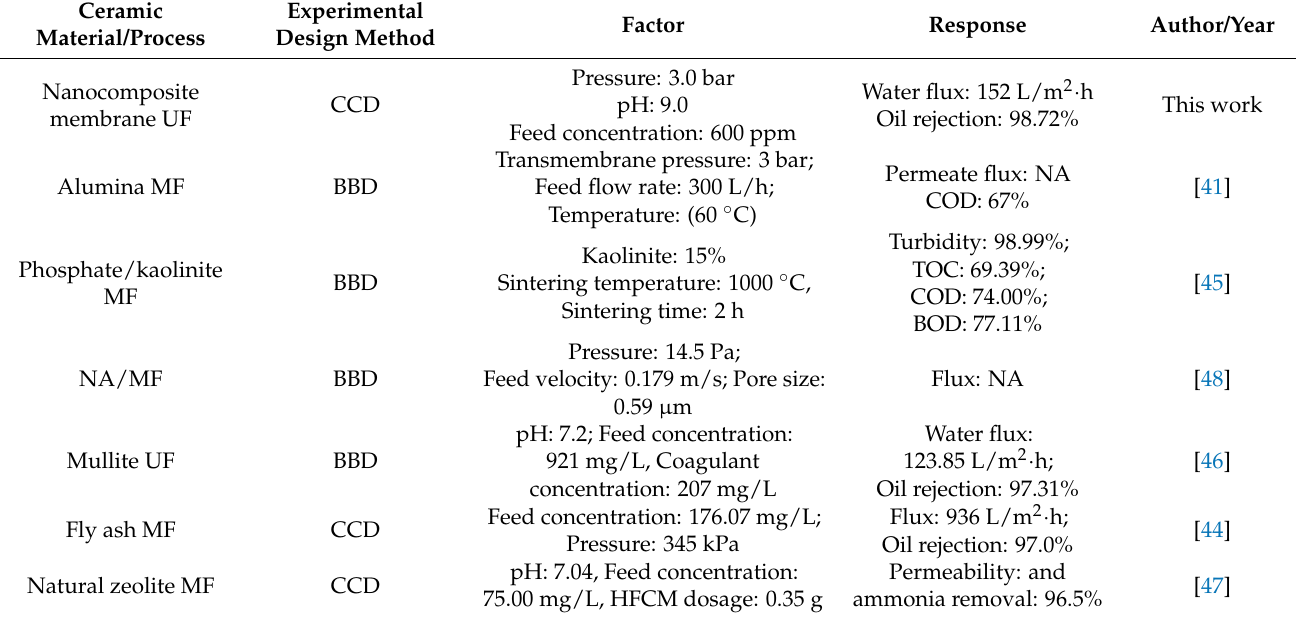
Table 6. Comparison of the ceramic-based membrane, optimization method, factors, and